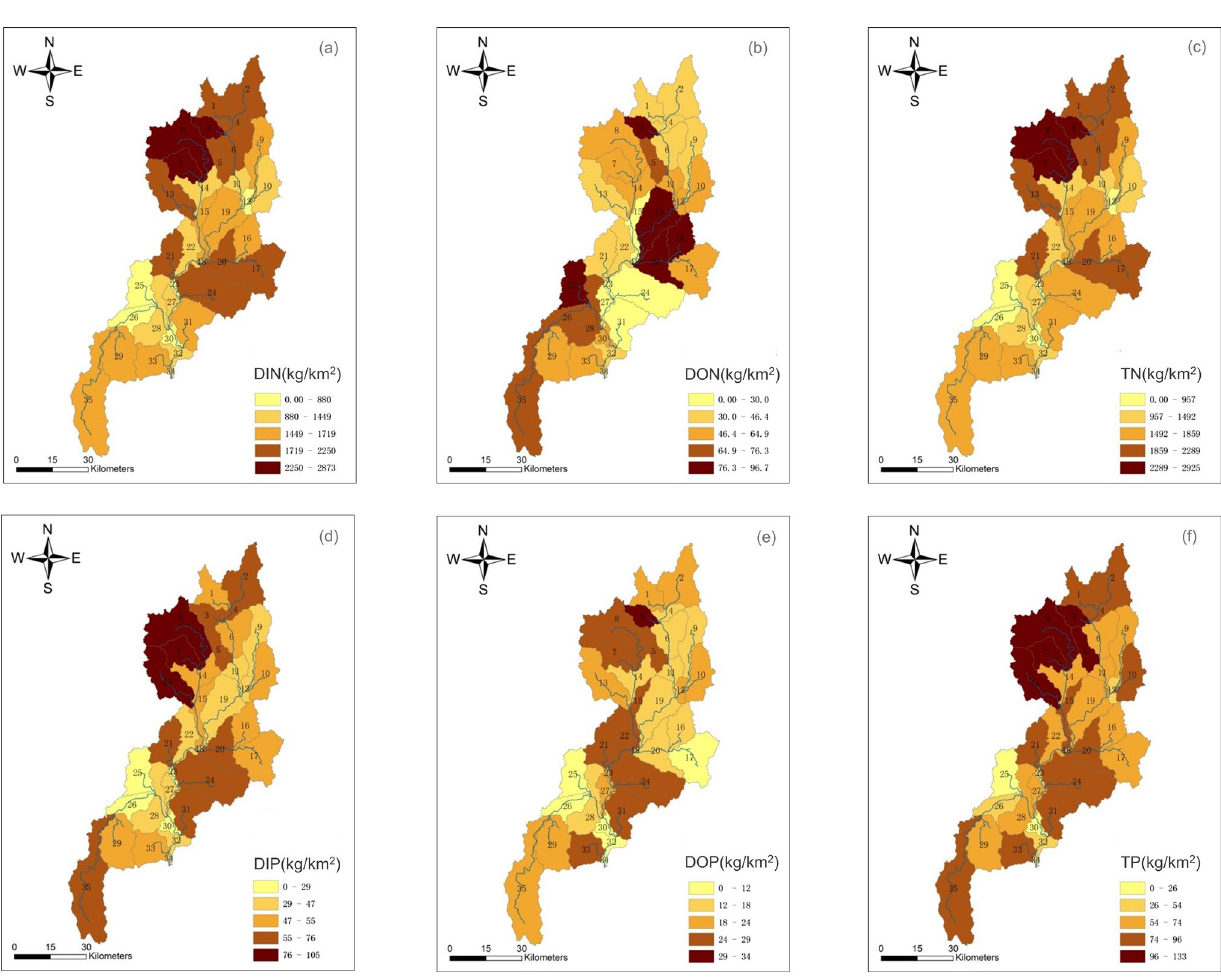
Fig. 8 Annual average emission density of nitrogen and phosphorus in sub-basins of Dagu River Basin: a DIN, b DON, c TN, d DIP, e DOP, f